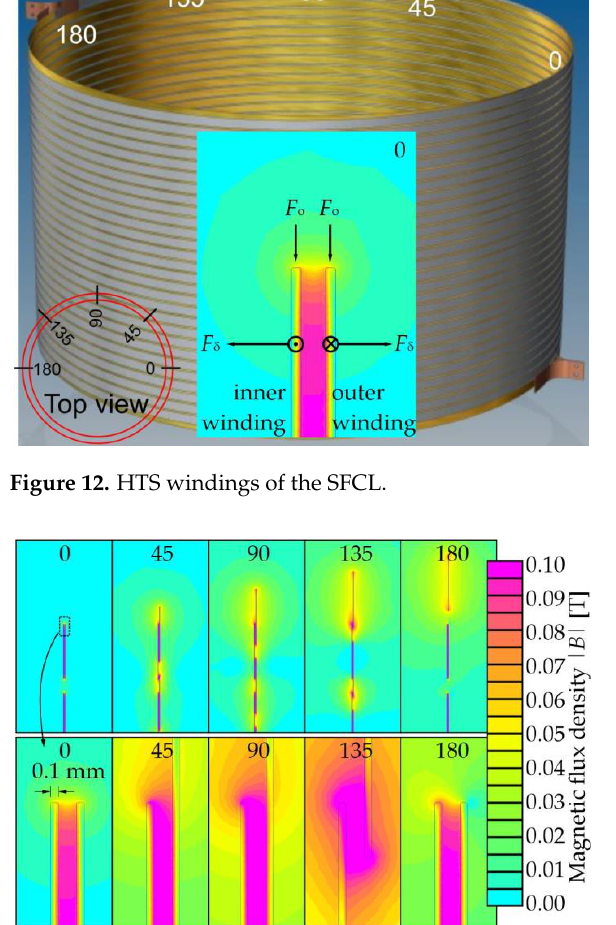
Figure 13. Magnetic flux density comparison at the angle 0 to 180 at the level of last turn. The magnetic flux density varies with the location (Figure 14). The radial component of the magnetic flux density is shown on Figure 15. The axial component of the magnetic flux density calculated between windings is shown on Figure